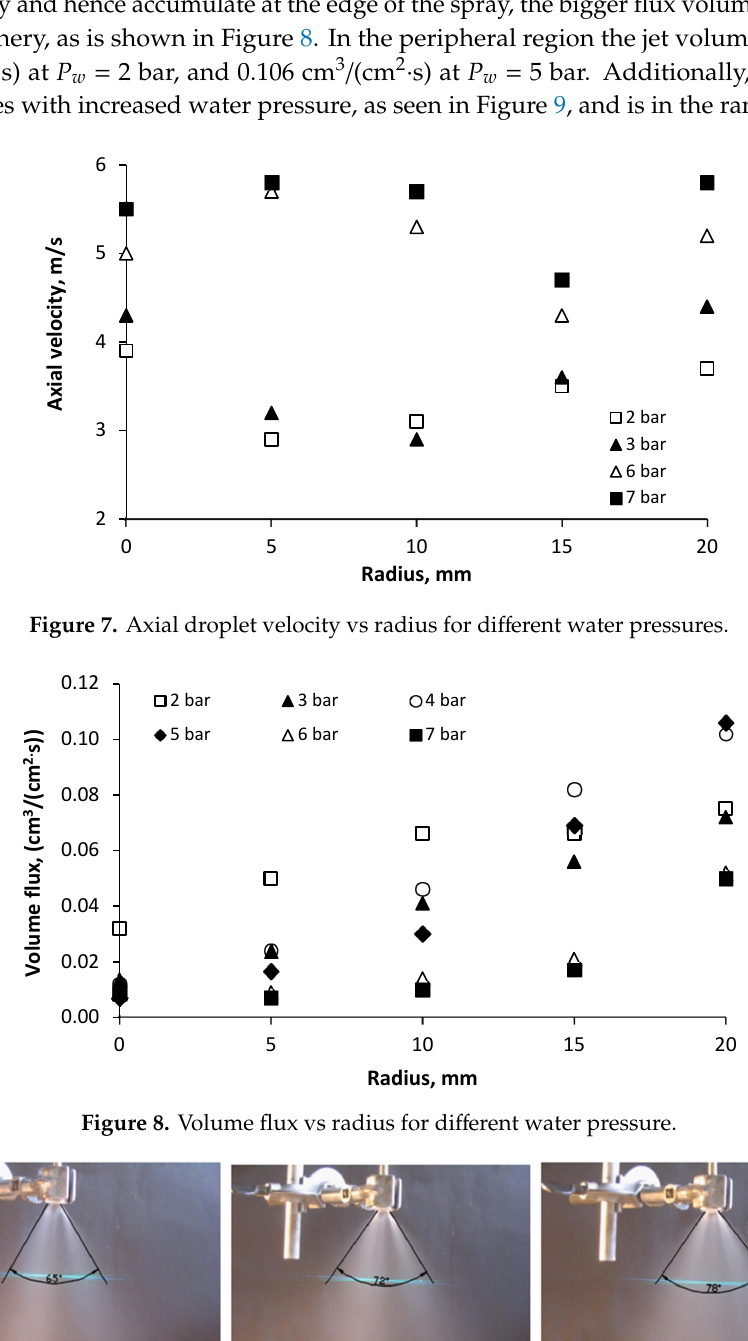
Figure 8. Volume flux vs radius for different water pressure. Figure 9. The spay torch angle ( β ) of the mechanical atomizer at varying water pressures: ( a ) 3 bar, ( b ) 4 bar, ( c ) 5 bar.